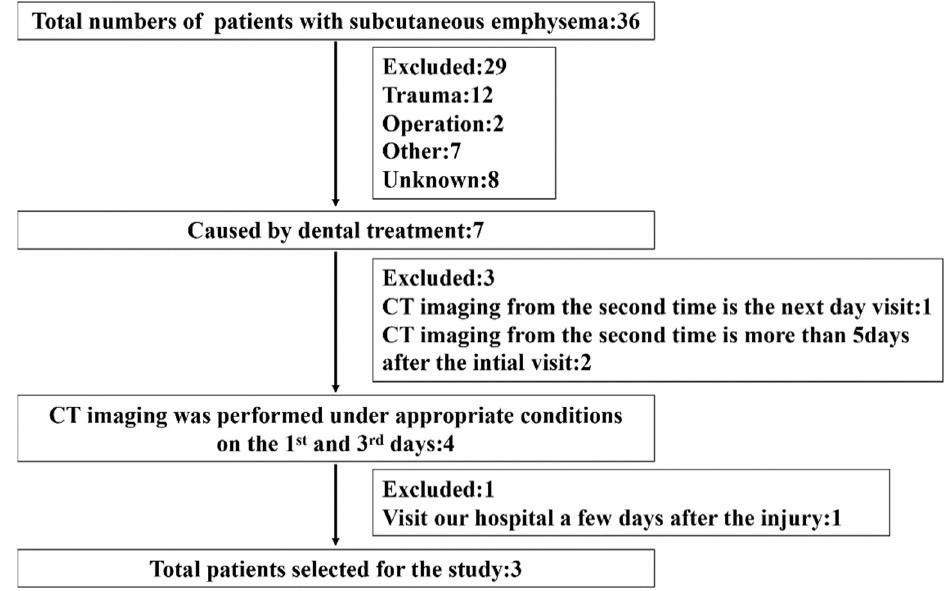
Figure 1. Flow diagram of the study representing the inclusion/exclusion criteria.